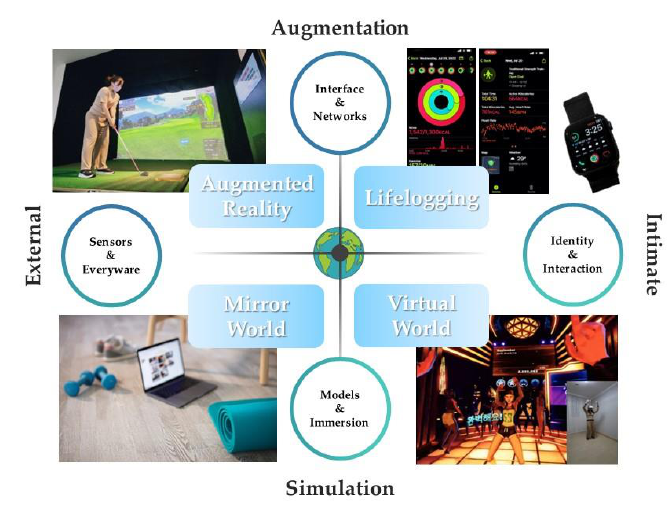
Figure 2. Four Types of Physical Education Areas of the Metaverse.